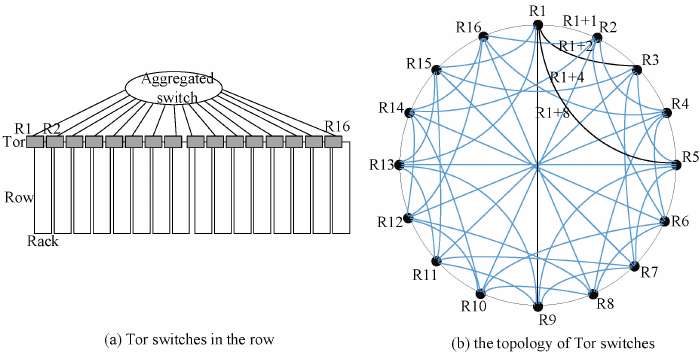
Figure 8. Topology of VCS modules.